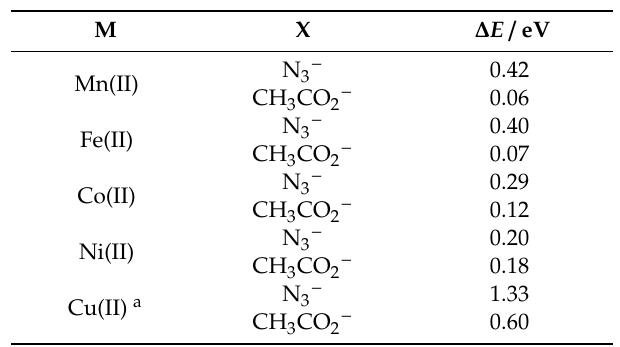
Table 2. Energy gap between the symmetric and antisymmetric combinations of the magnetic orbitals ( ∆ E ) in the FM state.